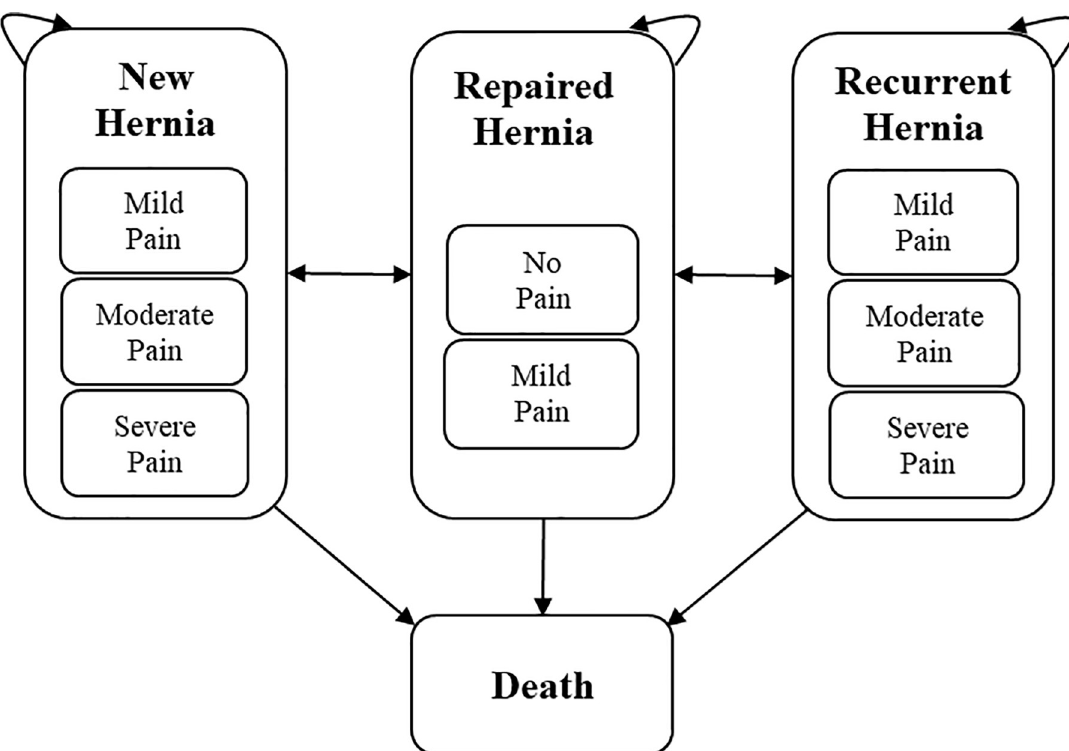
Fig 1. Markov model. All individuals simulated in the model start in the ‘New Hernia’ state in cycle zero. Depending on the user- defined rate of hernia repair (100% in the base-case analysis and starting from the current rate of 1.57% [9] and gradually expanded in the budget-impact analysis), patients can remain or move to the ‘Repaired Hernia’ state. Patients can then remain or move to the ‘Recurrent Hernia’ state based on the risk of recurrent hernia [26] or return to the ‘New Hernia’ state based on the risk of contralateral hernia [1]. Probabilities of having different pain levels in each health state were taken from the previous cohort study [14]. Transitions among the pain levels within each health state were not considered as the model only considers the presenting pain of the patients upon seeking care. Patients can move from any health state to the ‘Death’ state in each cycle. These transitions are based on age-dependent all- cause mortality risks according to the WHO’s life table for Ghana in 2016 and reported pre-mature mortality risks without surgery [19,20,23].The ‘Death’ state is an absorptive state in the model where simulated patients